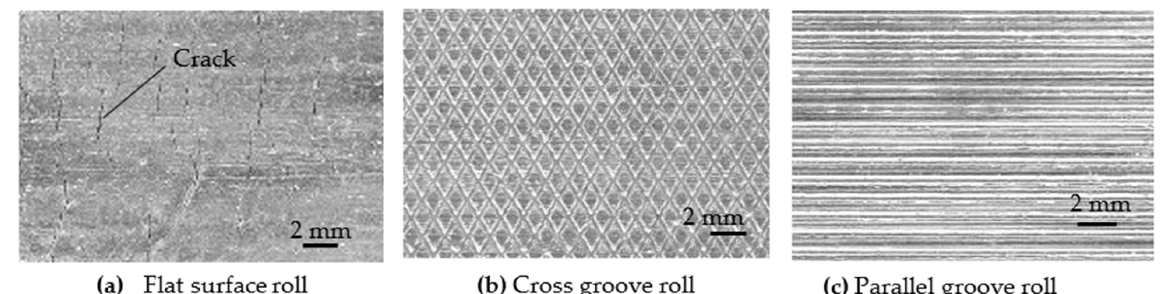
Figure 7. Strip surfaces cast using rolls with various roll orientations. Aluminum alloy: 6061, roll speed: 60 m/min, Roll load: 0.14 kN/mm, Roll diameter: 300 mm, Roll width: 50 mm. Solidification length: 100 mm.